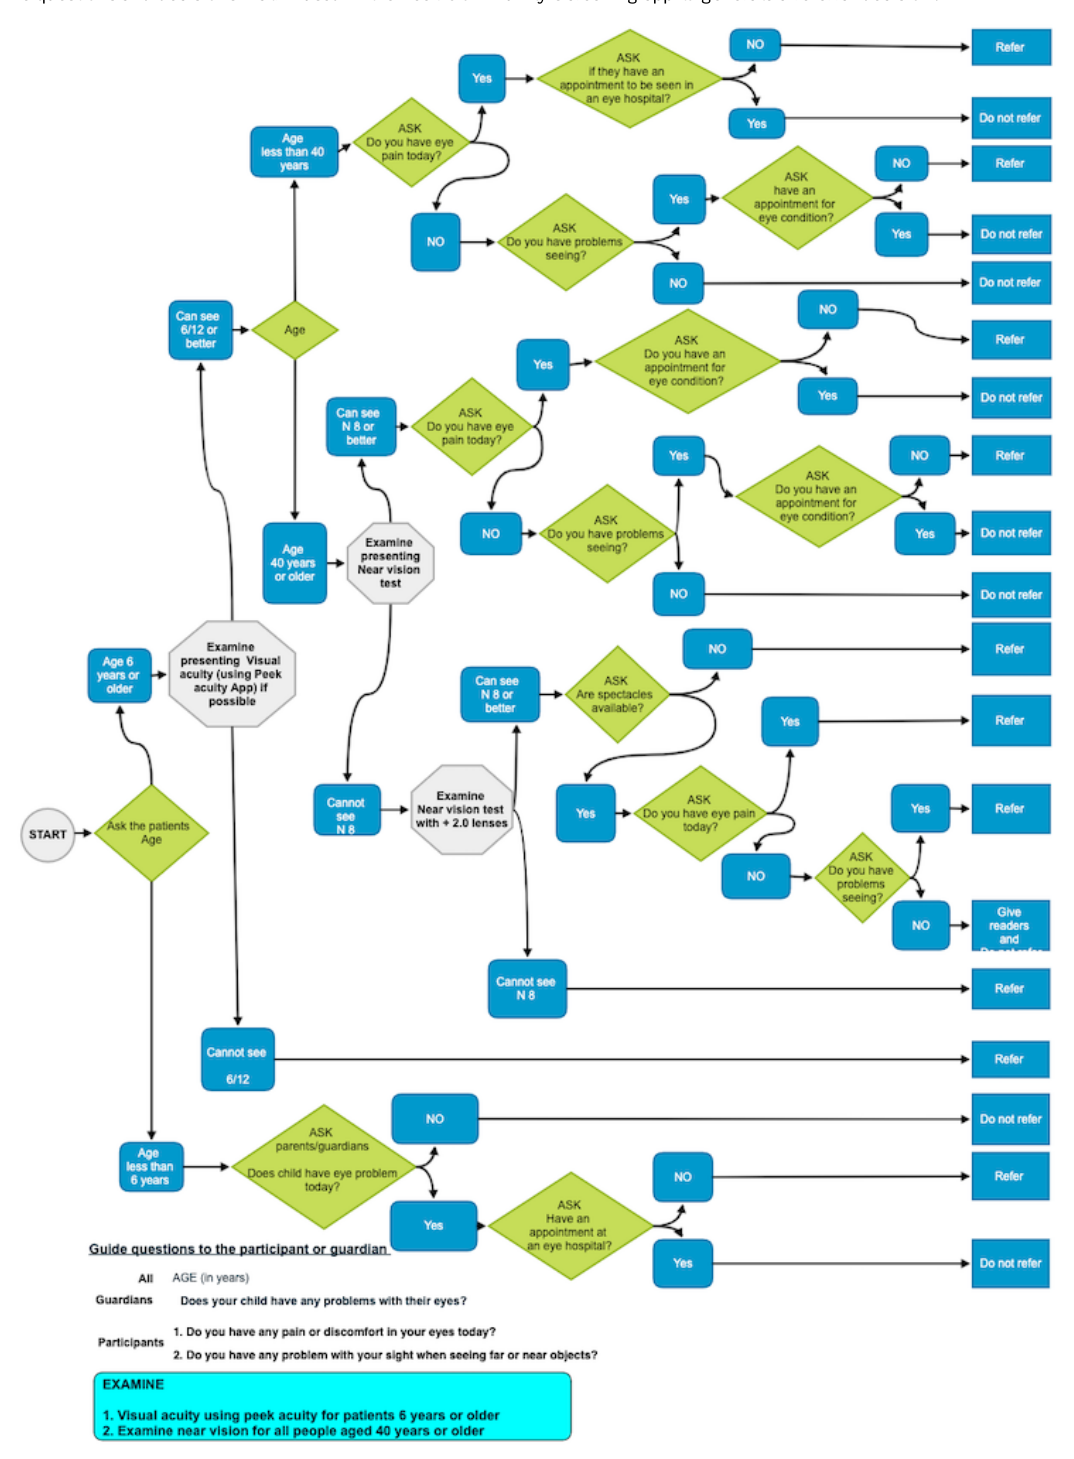
Figure 2. The questions and decisions matrix used in the Peek Community Screening app to generate a referral